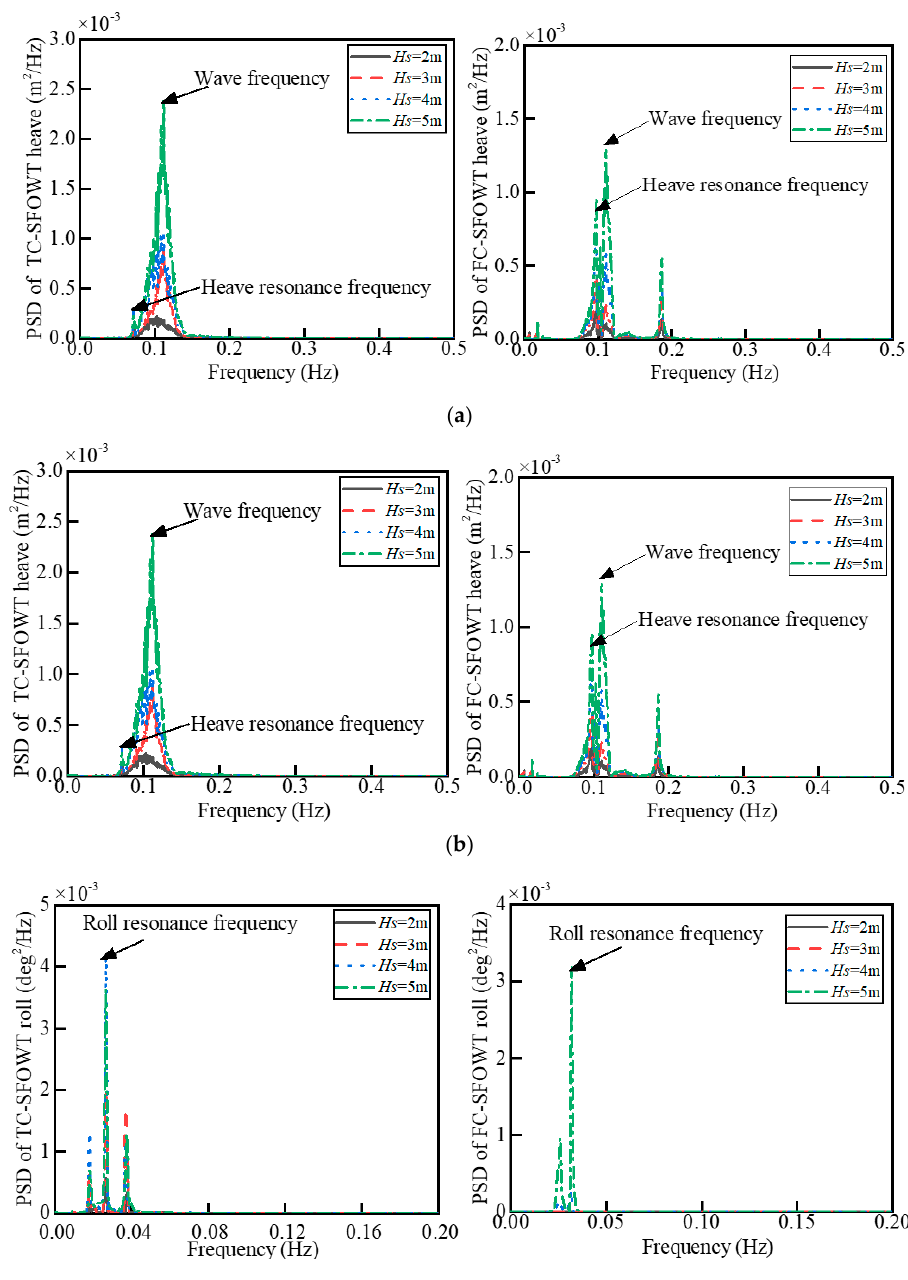
Figure 14. Power spectra of the SFOWT motion under different wave height conditions ( Tp = 8.9 s). ( a ) Heave motion, ( b ) pitch motion, ( c ) roll motion.